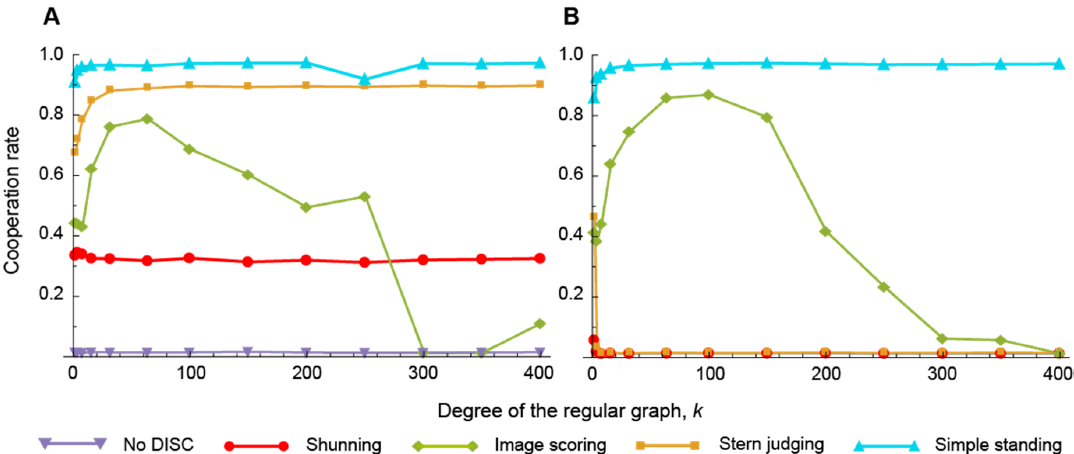
Figure 6. Effects of different node degrees on cooperation rates in simulations conducted for long periods. ( A ) With indirect observation and public assessment errors, shunning can only achieve the intermediate cooperation rate, and stern judging and simple standing can both consistently attain very high cooperation rates throughout almost all ranges of the node degree. Image scoring maximizes the cooperation rate at a node degree of around 64, which will decrease to zero as increases occur in the node degree. In the case with no DISCs, no cooperation evolves for any node degree. ( B ) With direct observation and private assessment errors, shunning achieves no cooperation for any node degree (except k = 2). Simple standing can maintain full cooperation, as shown in ( A ); however, in this case, stern judging cannot, which can lead to, at most, an intermediate cooperation rate only for k = 2 and an almost zero rate for any other node degree. Image scoring can lead populations to push the cooperation rate to its maximum for relatively small node degrees, which decreases, as shown in ( A ). Parameters: g = 200 generations, h = 1000 periods, implementation error rate p = 0.01, public and private error rates q = 0.01, selection intensity s = 1, mutation rate m = 0.01, degree = {2, 4, 8, 16, 32, 64, 100, 150, 200, 250, 300, 350, and 400}, c = 1, and b = 5. Cooperation rates depicted are the average calculated over 20 independent runs of the agent ‐ based simulation.